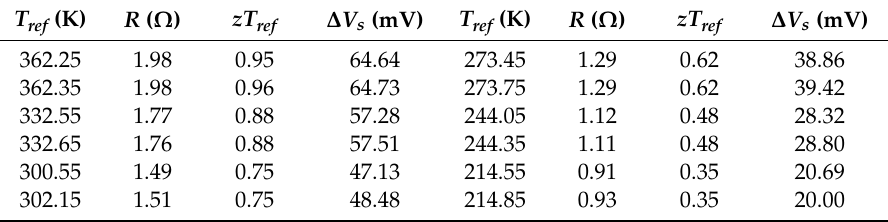
Table 3. Peltier module a.2: p - n series resistance, the figure of merit, and Seebeck voltage ( I = 41 mA).